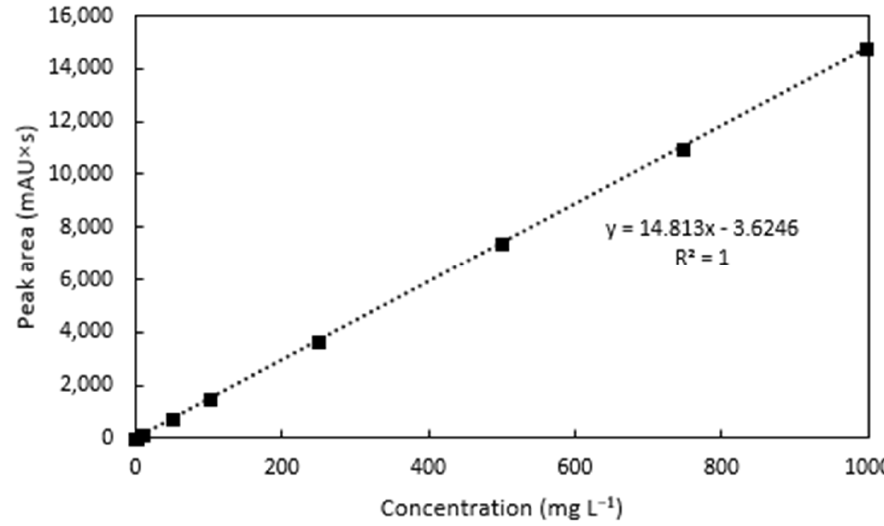
Figure 5. Linearity of the tebuthiuron standards.